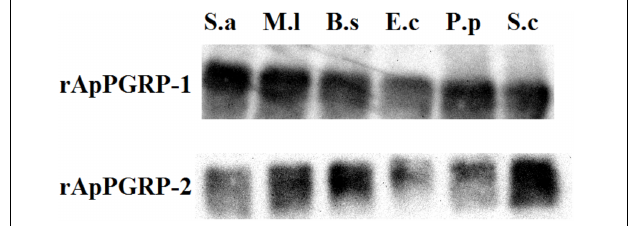
FIGURE 7 | The combination of rApPGRP-1 and -2 with live microbes as detected using western blot. S.a, Staphylococcus aureus ; M.l, Micrococcus lutea ; B.s, Bacillus subtilis ; E.c, Escherichia coli ; P.p, Pichia pastoris ; S.c, Saccharomyces cerevisiae.